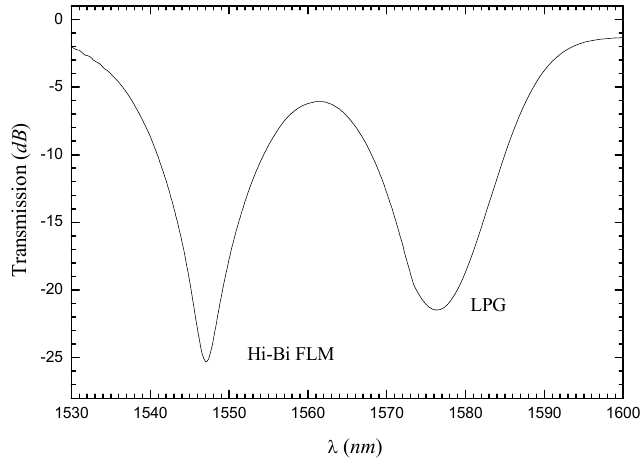
Figure 8. Spectral response of a concatenated Hi-Bi FLM and LPG.